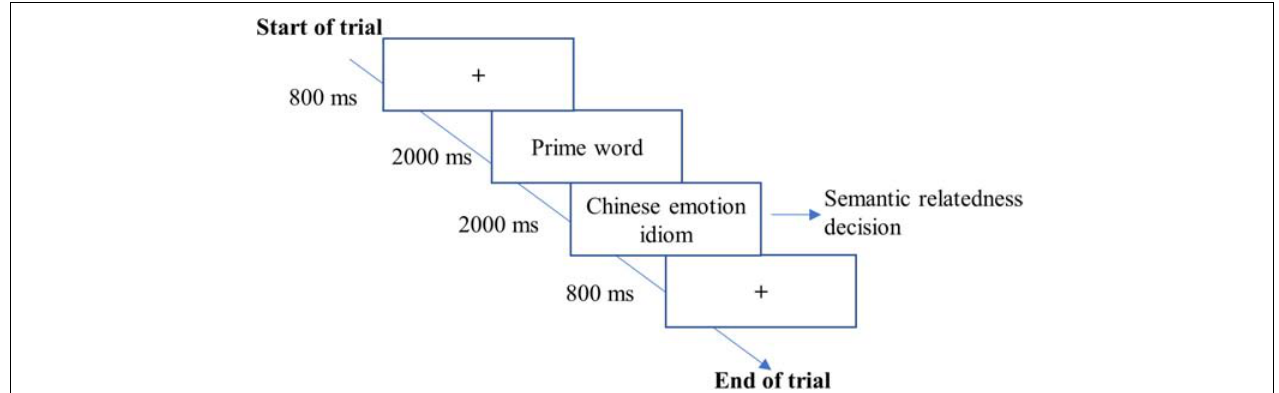
FIGURE 2 | A trial used in Experiment